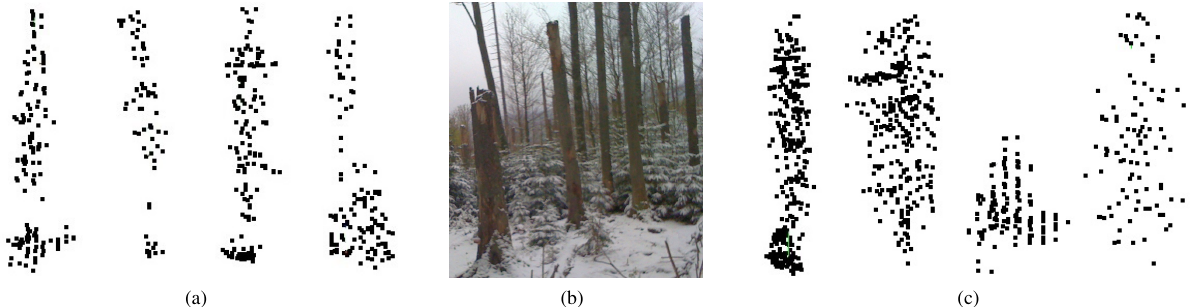
Figure 1: Examples of ALS point clouds of dead trunks (a) and other forest structures (c). The other objects include slender trees, small bushes/ground vegetation, and trees that were poorly captured in the point cloud due to low point density. (b) shows an optical image of several dead trunks surrounded by small trees near the